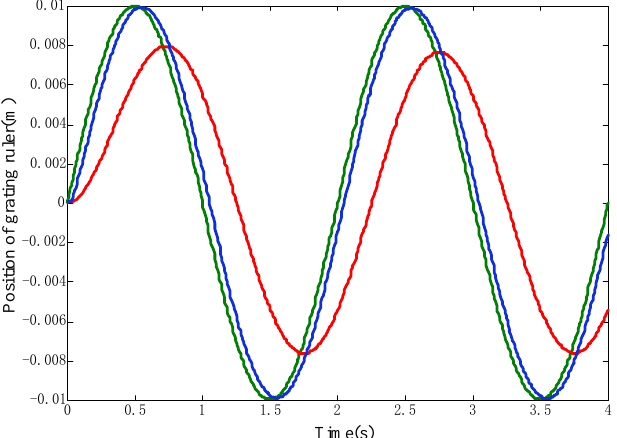
Figure 8. Variation of the grating ruler position (the proposed method in the blue line, PID controller in the red line, and the desired sine signal in the green line).